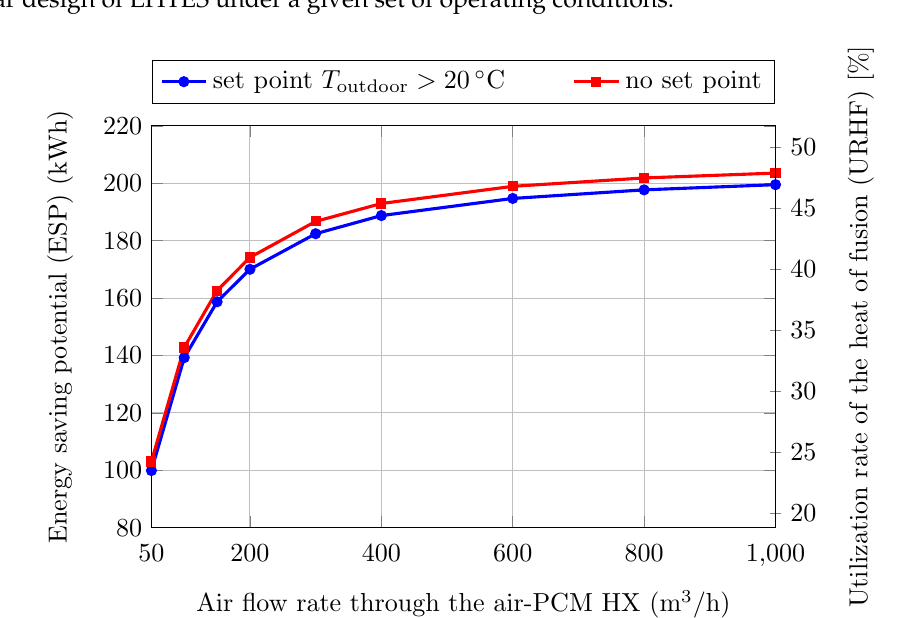
Figure 8. Energy saving potential (ESP) and the utilization rate of the heat of fusion (URHF) for Madrid and the nominal phase change temperature T mpc = 24 ◦